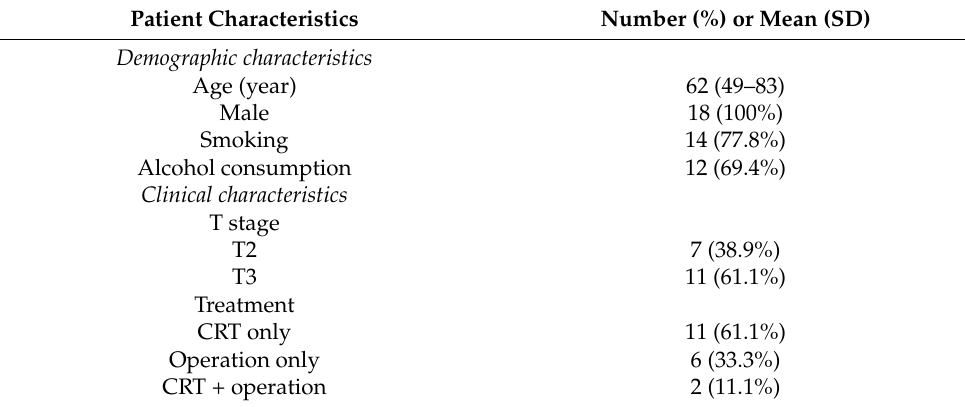
Table 1. Characteristics of the enrolled patients in this study.